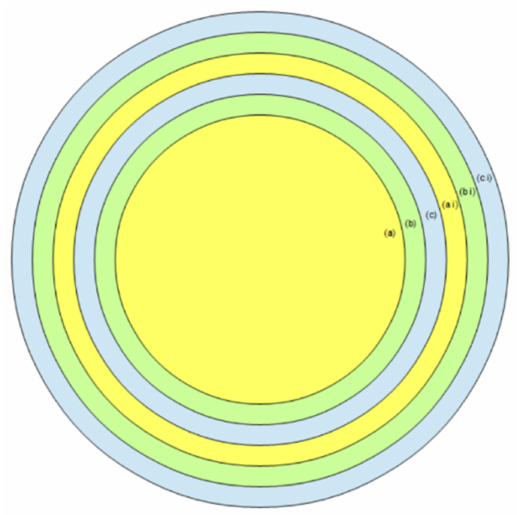
Figure 8. Virion Cluster, x–z section model.